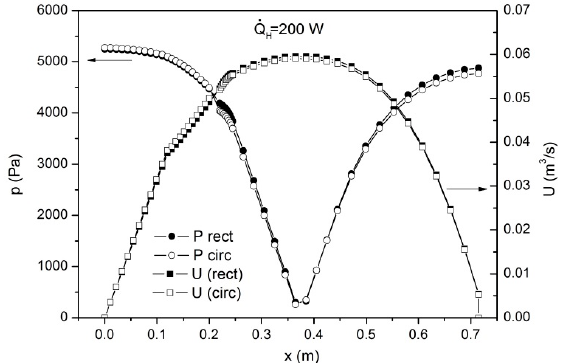
Figure 6. The axial distribution of the acoustic pressure amplitude and volumetric velocity